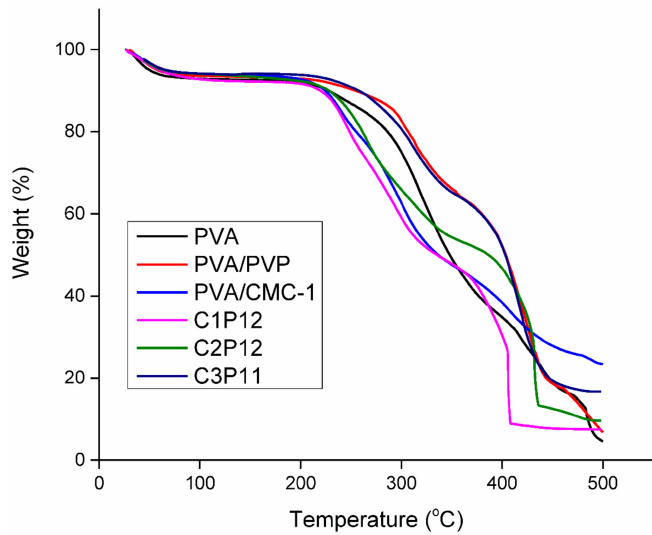
Figure 5. Thermogravimetric analyzer (TGA) plots of PVA, PVA/PVP, and CMC based composite nanofibers representing thermal degradation behavior of nanofibers.